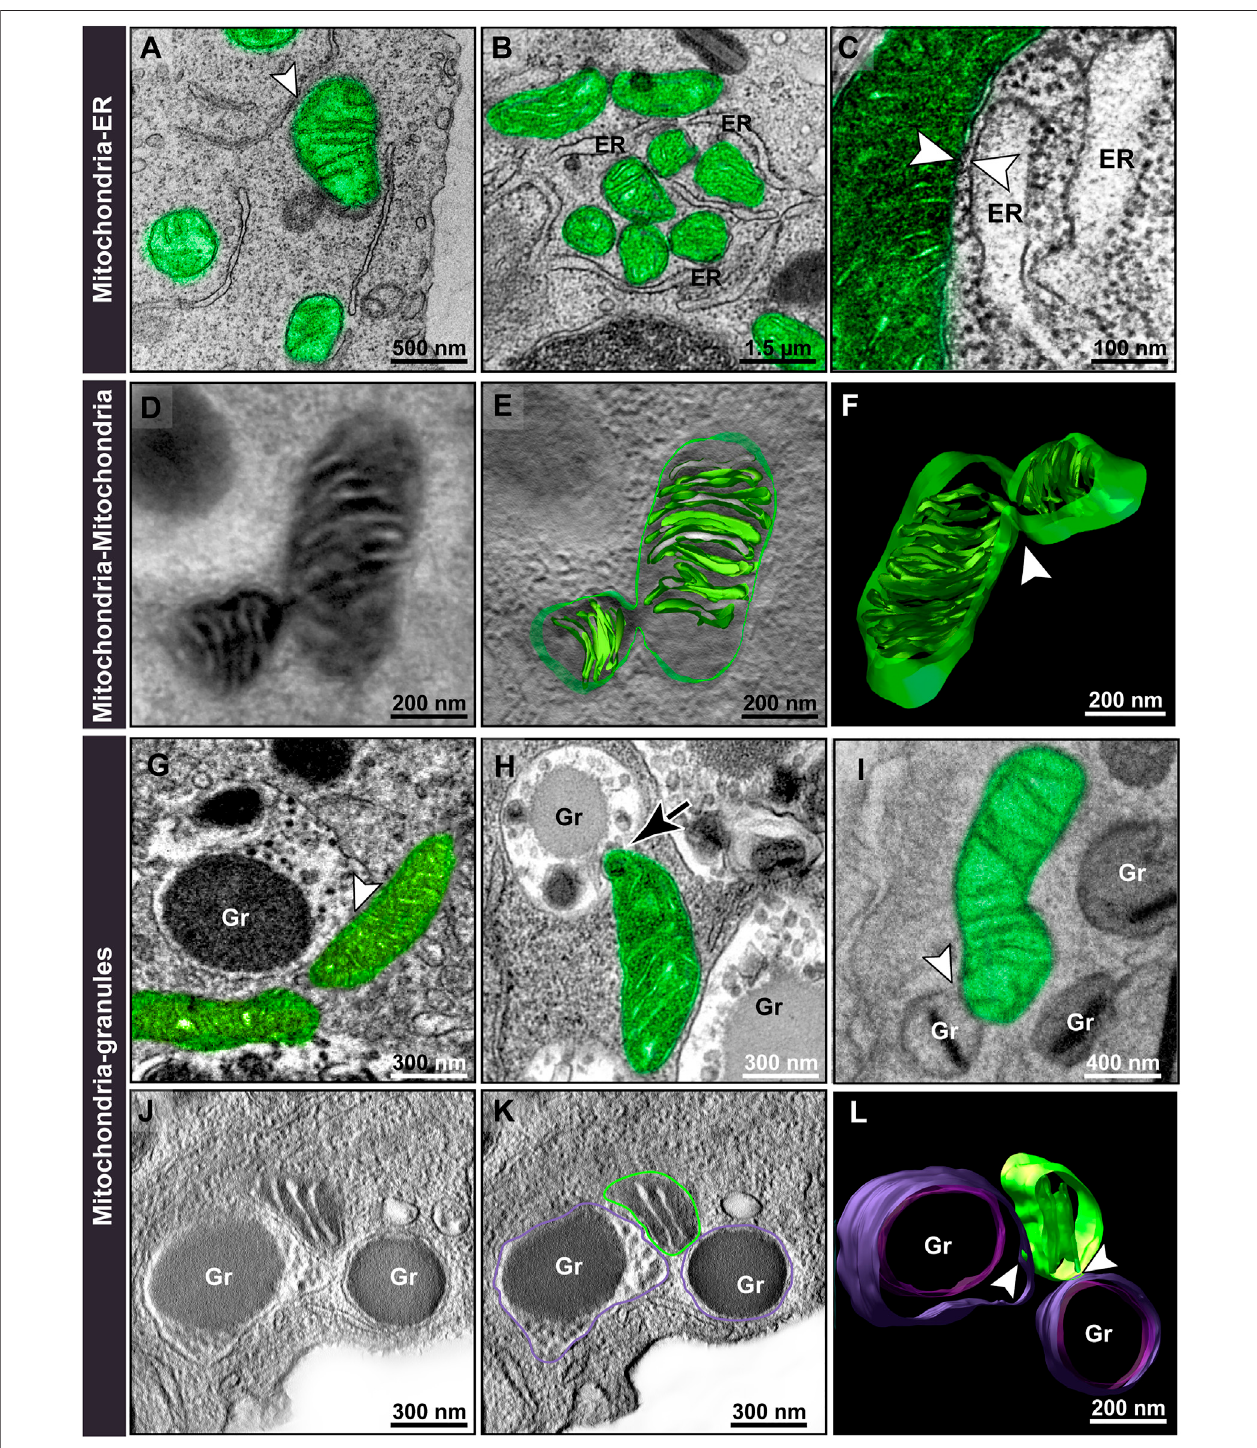
FIGURE 4 | Mitochondrial interactions within immature and mature eosinophils. During eosinophilopoiesis, membrane contact sites (arrowheads) are observed between mitochondriaand the endoplasmic reticulum (ER) (A – C) ; other mitochondria (D – F) ; and secretory granules (G – L) , mainly with coreless granules (G,H) . Note in (H) ,amitochondrionprotrudingintoacorelessgranuleinprocessofcontent fi lling(arrow)whilein (I) ,amitochondrioncontactsafullymaturegranulecontainingatypical electron-dense core (arrowhead). (D – F) and (J – L) show representative slices of tomograms and 3D models of mitochondria-mitochondria and mitochondria- granules (J – L) interactions, respectively. Virtual slices were extracted from 3D reconstructions of a 200 nm eosinophil section analyzed by fully automated electron tomography at 200 kV. Samples were prepared for conventional TEM and electron tomography as before (Melo et al., 2005). Mitochondria were pseudocolored green. Gr, speci fi c